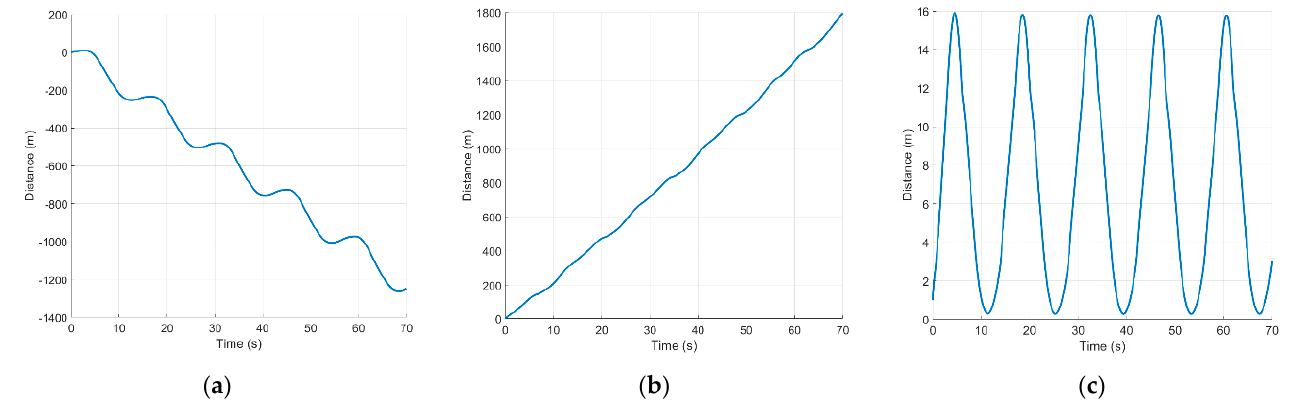
Figure 12. The three directions the UAV traveled. ( a ) North direction flight distance; ( b ) East direction flight distance; ( c ) Altitude flight distance.